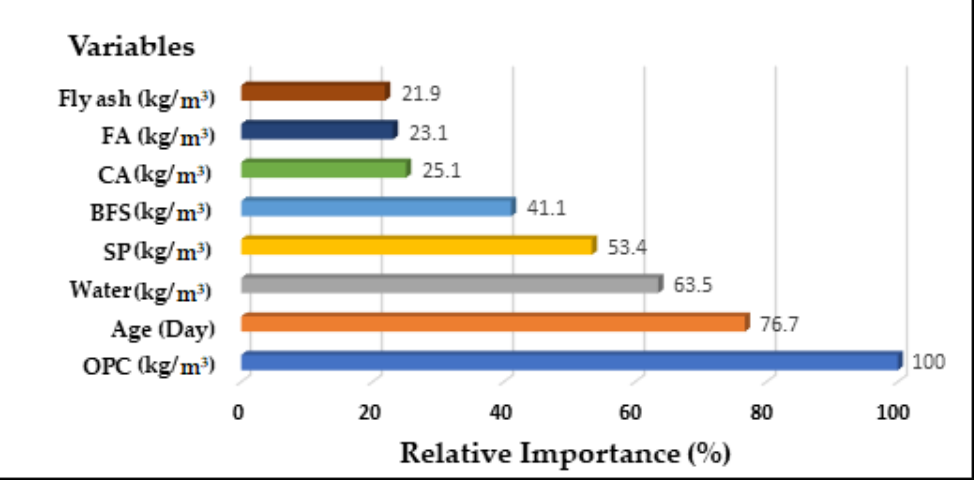
Figure 11. Relative Variable Importance for Different Factors .